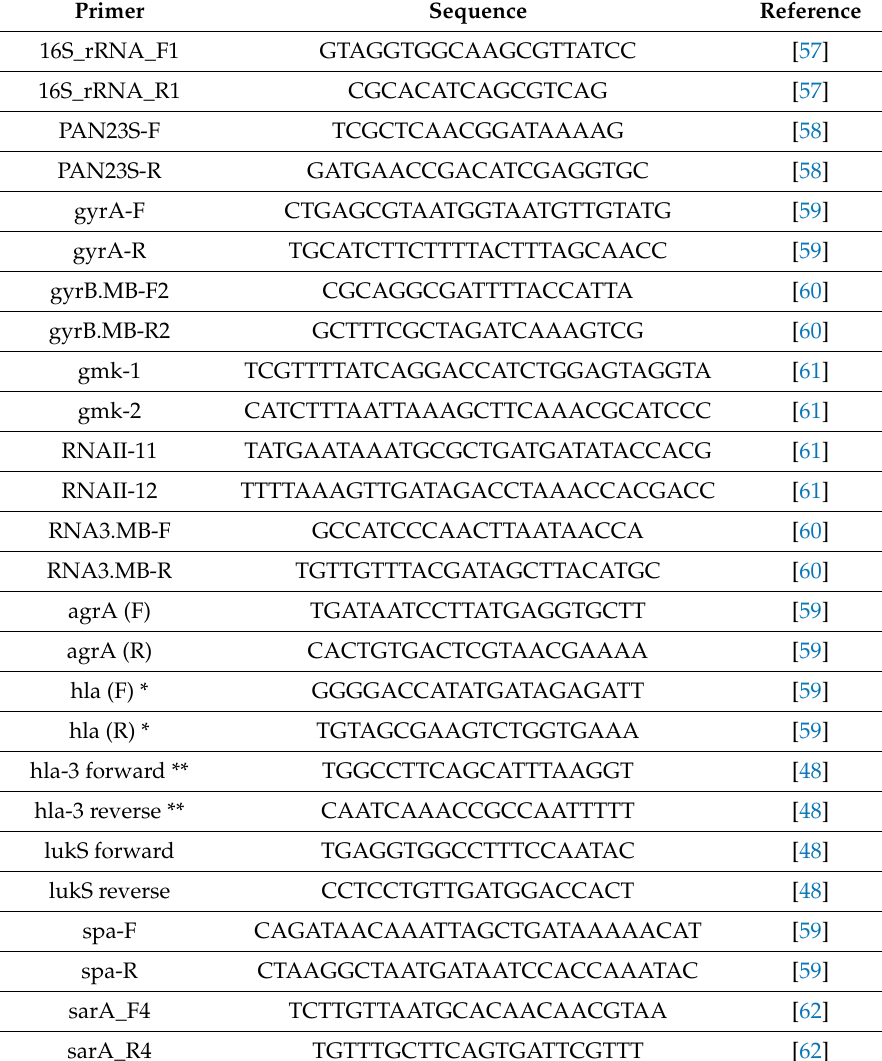
Table 2. Primers used for qPCR